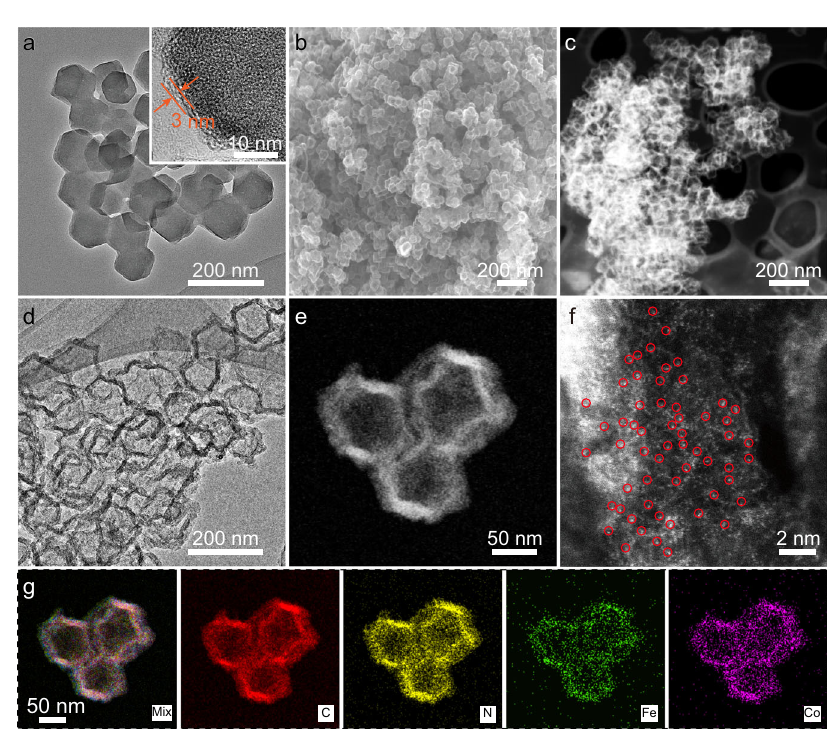
Fig. 2| StructuralcharacterizationsofFeCo-NCH.a TEMimage of the ZIF-8@ZIF-67@Fe@PDA(inset:HRTEMimage), b SEM image, c , d TEMimages, e , f HAADF-STEM images, and g elemental mappings of the